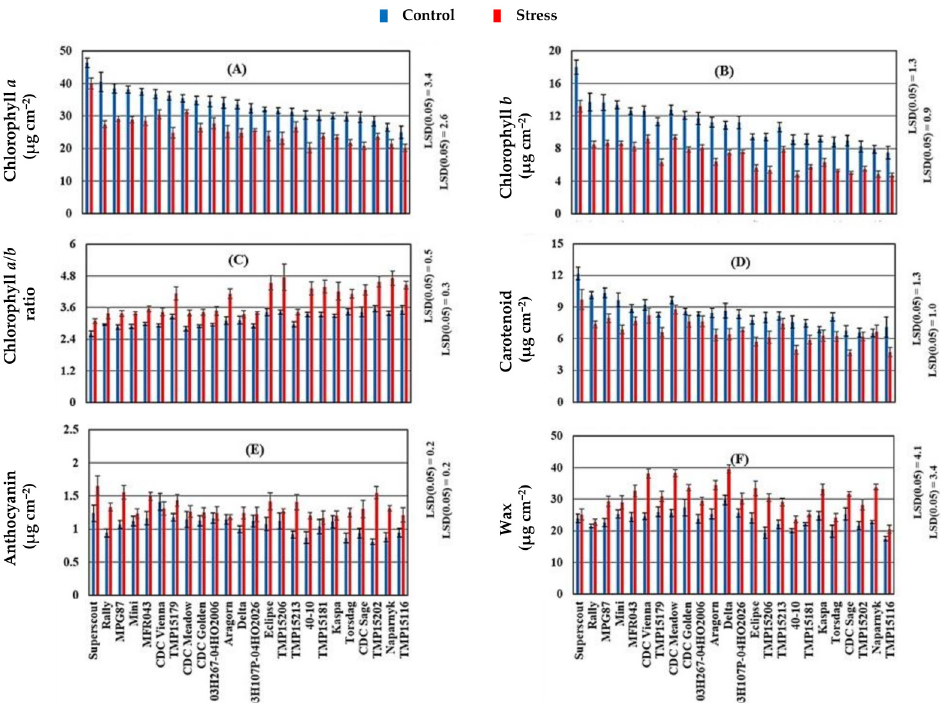
Figure 1. Mean lamina pigment and wax concentrations of 24 pea cultivars grown in control (blue) and stress (red) conditions, with ( A ) chlorophyll a, ( B ) chlorophyll b, ( C ) chlorophyll a/b ratio, ( D ) carotenoid, ( E ) anthocyanin and ( F ) wax concentrations ( µ g cm − 2 ). Each bar represents the mean values, and error bars are the standard error of the mean. For each bar, N = 16 (two environments × four replications × two growth stage samples) for each of control or stress condition. The LSD values for each of the stress levels is shown in the figure. The control conditions are 2014 late seeding date at Rosthern and 2016 normal seeding date at Saskatoon; and the stress conditions are 2015 late seeding date at Rosthern and Saskatoon, Canada.